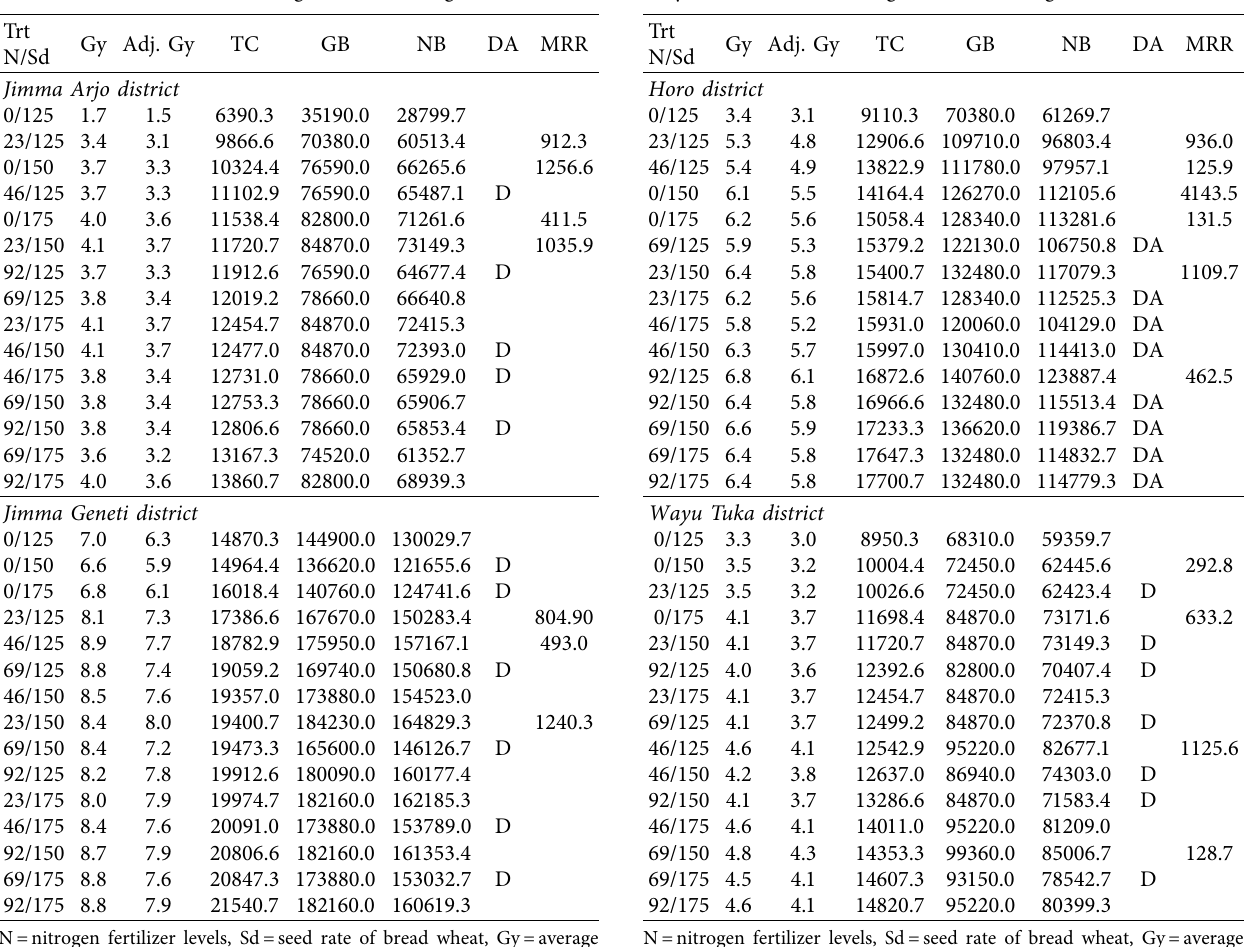
Table 8: Te efects of N fertilizer application and seed rate on the economic proftability of bread wheat production at Jimma Arjo and Jimma Geneti districts during 2020 under irrigation condition.